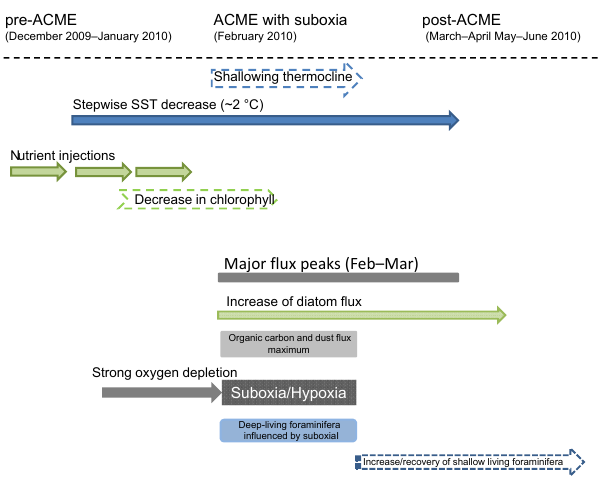
Figure 10. Schematic timeline of inferred processes within the ACME (surface waters and the anoxic/hypoxic water column be- low), which approached and passed the CVOO site in the begin- ning of 2010. Important sediment trap flux signatures are indi- cated. We assume a rapid transmission of the surface signature from the ACME to the bathypelagic sediment traps of only 1–3 weeks, mainly due to high particle settling